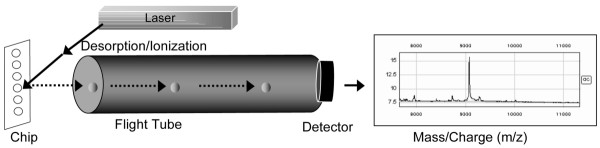
SELDI-TOF MS technique. Serum samples are spotted onto IMAC-3 copper chips® (Ciphergen Biosystems). The chip is irradiated with a laser, resulting in ionization of the adherent molecules. The ions travel through a vacuum tube and their mass-to-charge ratios are calculated from their time of flight through the vacuum chamber. IMAC-3, immobilized metal affinity capture; SELDI-TOF MS, surface-enhanced laser desorption/ionization time-of-flight mass spectrometry.